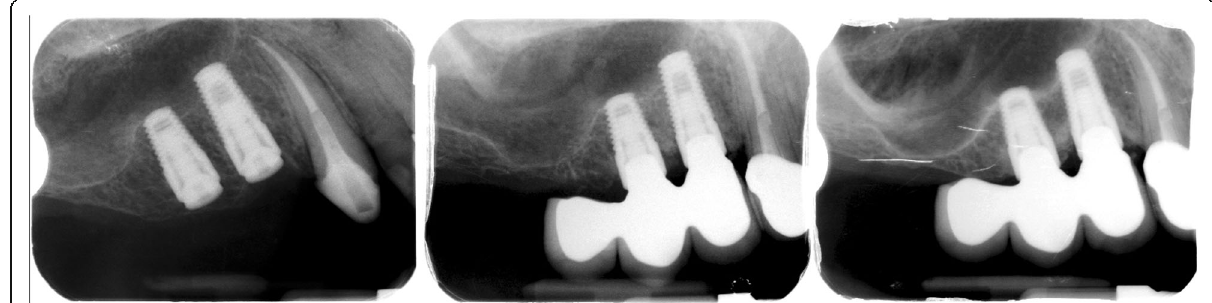
Fig. 3 Illustrative case of radiological follow-up period of two adjacent implants in the maxilla. T0 in the left image, T1 in the central, and T2 in the right